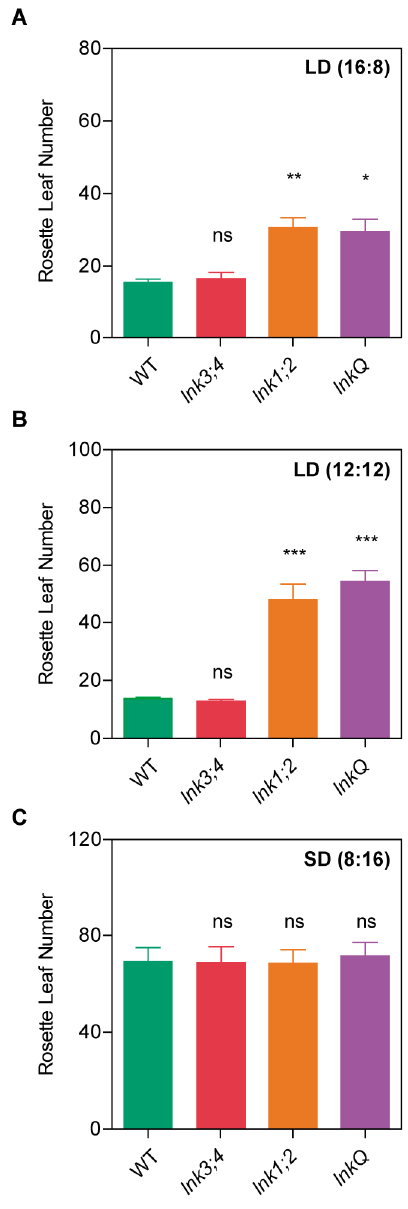
Figure 2. LNK1 and LNK2 , but not LNK3 or LNK4 , play a role in the photoperiodic control of flowering. Flowering time measured as the number of rosette leaves at bolting in ( a ) long days (LD; 16:8), ( b ) 12 h light: 12 h dark cycles (LD; 12:12), and in ( c ) short days (SD; 8:16). Error bars indicate SEM. Student’s t -test was performed between mutants and WT (*: significantly different, p ≤ 0.05; **: significantly different, p ≤ 0.01; ***: significantly different, p ≤ 0.001; ns: not significant).